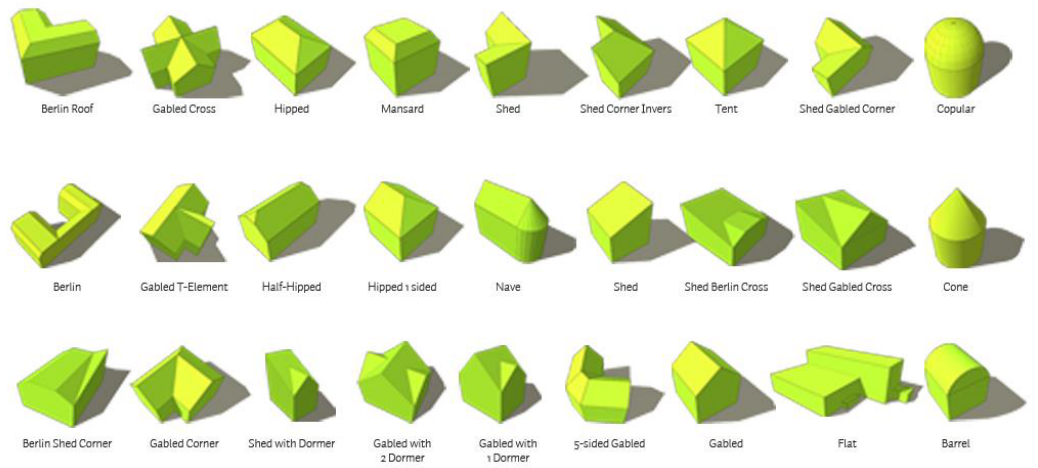
Figure 12. BuildingReconstruction 2018 software roof library [ 38 ].